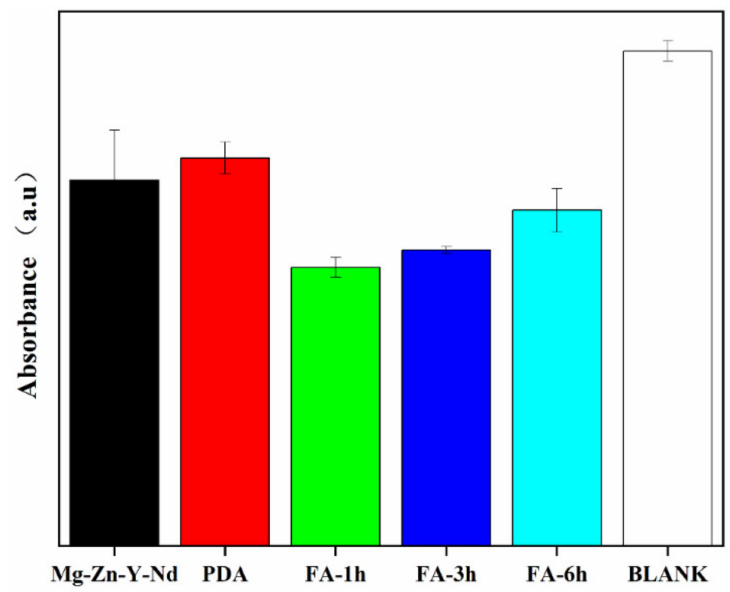
Figure 12. DPPH radical content of